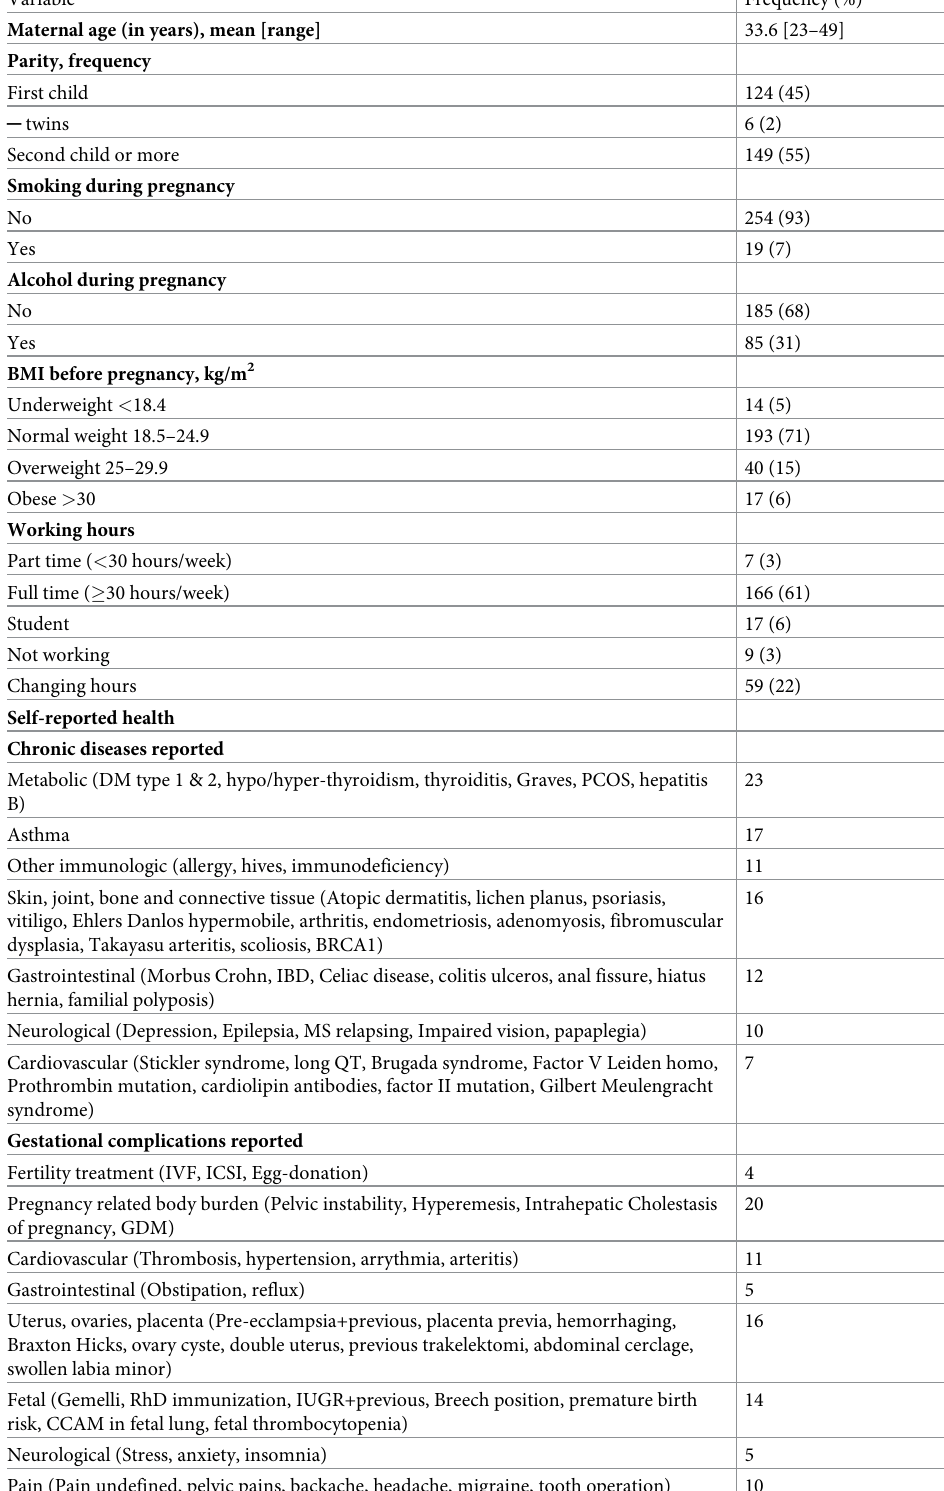
Table 2. Characteristics of the study population (n =